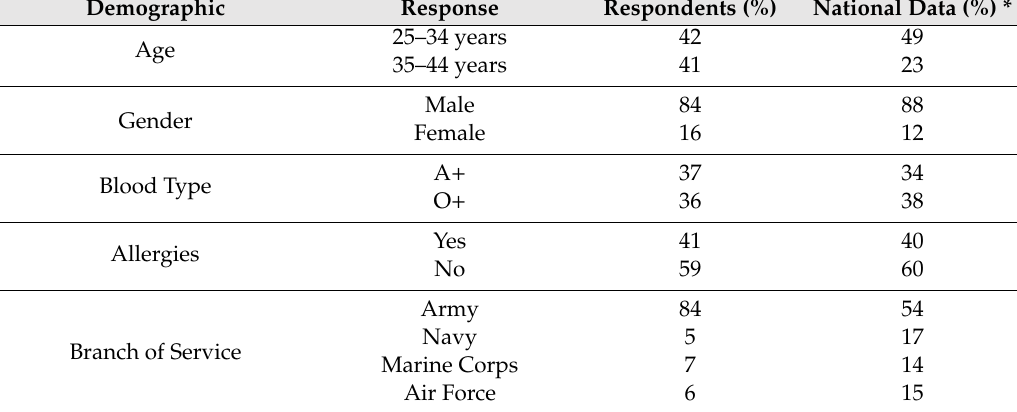
Table A1. Demographic Data